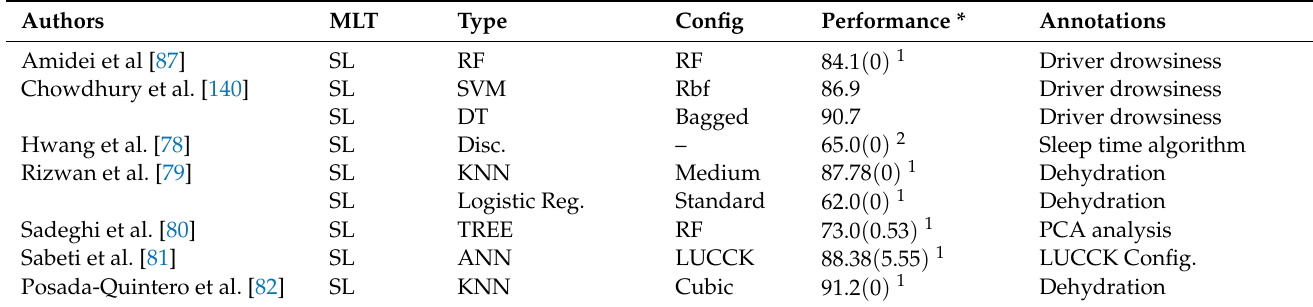
Table 17. Supervised learning methods for classification of other